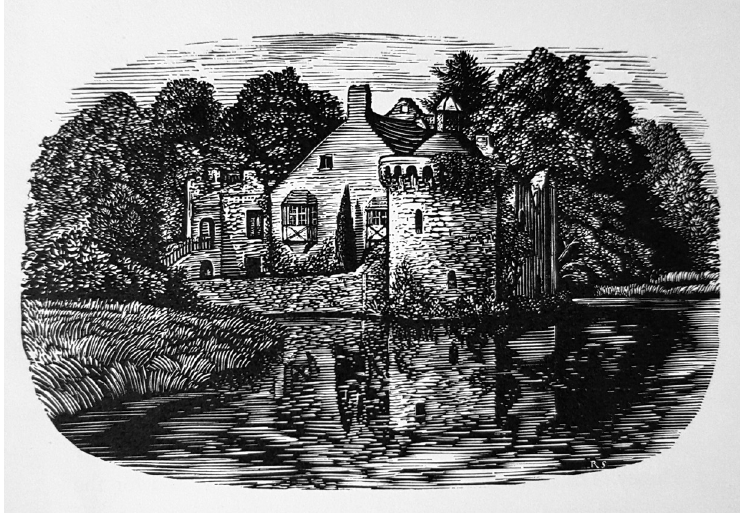
Figure 2 Illustration for Boxwood poem XXI. Image courtesy of the Estate of Reynolds